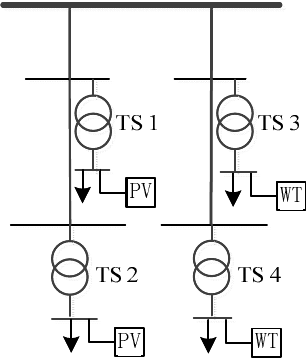
Figure 1. Simulation figure of substations within a cluster.